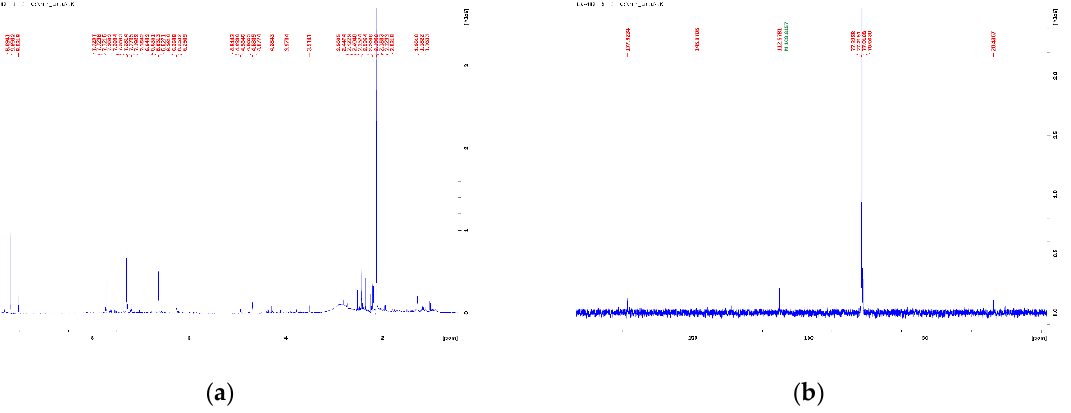
Figure 5. ( a ) 1 H NMR spectrum and ( b ) 13 C NMR spectrum of the pyrolysis oil of the macroalgae Cladophora glomerata .